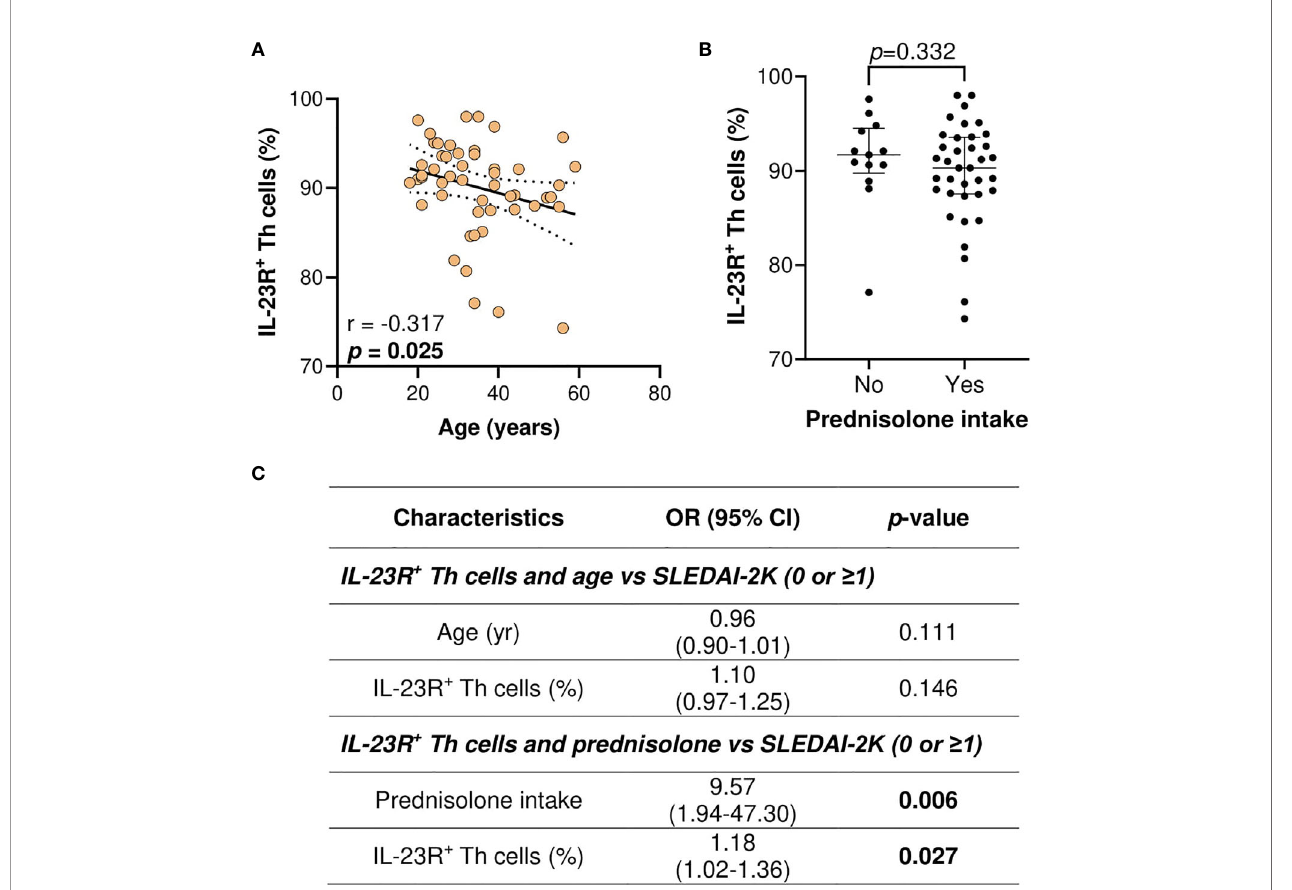
FIGURE 5 | Association of IL-23R + Th cells (%), age (years), and prednisolone intake with the SLEDAI-2K scores in SLE patients. (A) Association of IL-23R + Th cells with age in SLE patients. (B) Association of IL-23R + Th cells with prednisolone intake in SLE patients. (C) Multivariate analysis of IL-23R + Th cells and age or prednisolone intake vs SLEDAI-2K (0 or ≥ 1) in SLE patients (n =